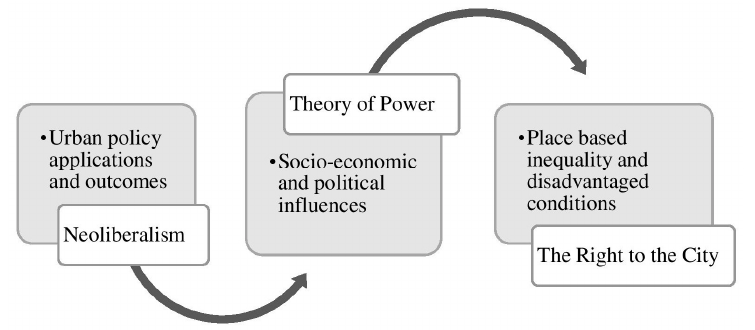
Figure 3. Critical urban thoughts applied in this research. Source: authors’ own.